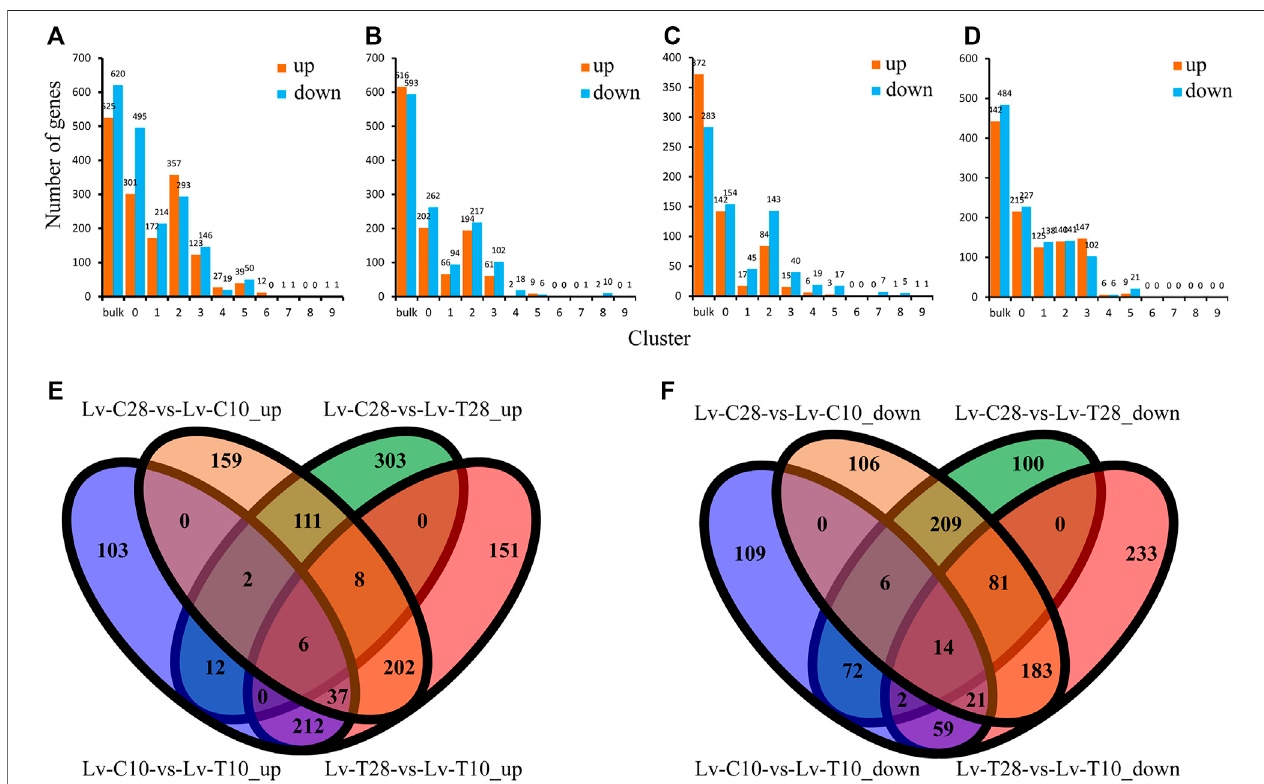
FIGURE 2 | Differentially expressed genes (DEGs) between cold-tolerant and common Litopenaeus vannamei at 10 ° C and 28 ° C. (A – D) Differentially expressed genesacrossallcellcultures(Total)andincellclusters0 – 9forthefollowingcomparisons: (A) Lv-C28-vs-Lv-C10(commonat28 ° Cversuscommonat10 ° C), (B) Lv-T28- vs-Lv-T10 (cold-tolerant at 28 ° C versus cold-tolerant at 10 ° C), (C) Lv-C10-vs-Lv-T10 (common at 10 ° C versus cold-tolerant at 10 ° C), and (D) Lv-C28-vs-Lv-T28 (commonat28 ° Cversuscold-tolerantat28 ° C). (E,F) Venndiagramsshowingthe (E) upregulatedand (F) downregulatedgenessharedanduniqueamongthefour